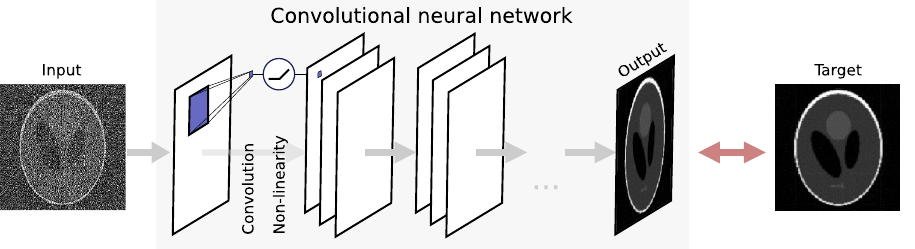
Figure 1. A prototypical convolutional neural network (CNN) in a supervised training arrangement for denoising. The CNN is composed of multiple layers. To compute an image in the next layer, images in the previous layer are convolved with a small filter (depicted in blue), after which a non-linear function is applied. To train a CNN to perform denoising, the output image is compared to a target image, and the convolution filters are updated